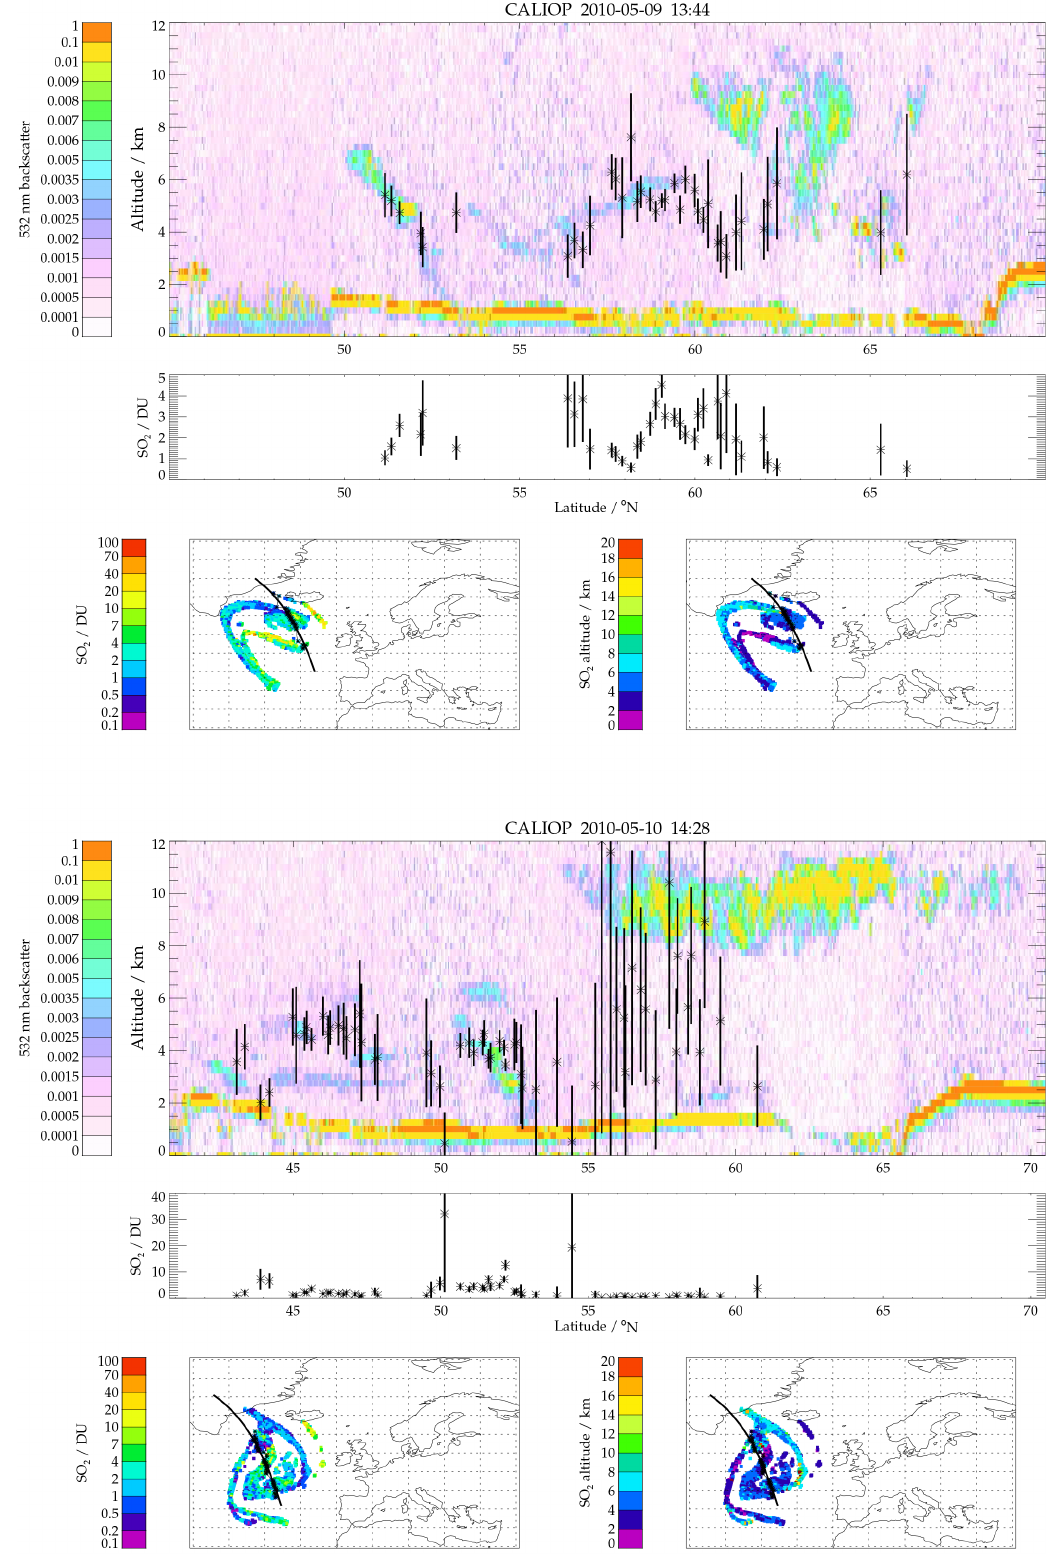
Figure 2. CALIOP-IASI coincidences for the 9 and 10 May 2010, Eyjafjallajökull plume. As Fig. 1.